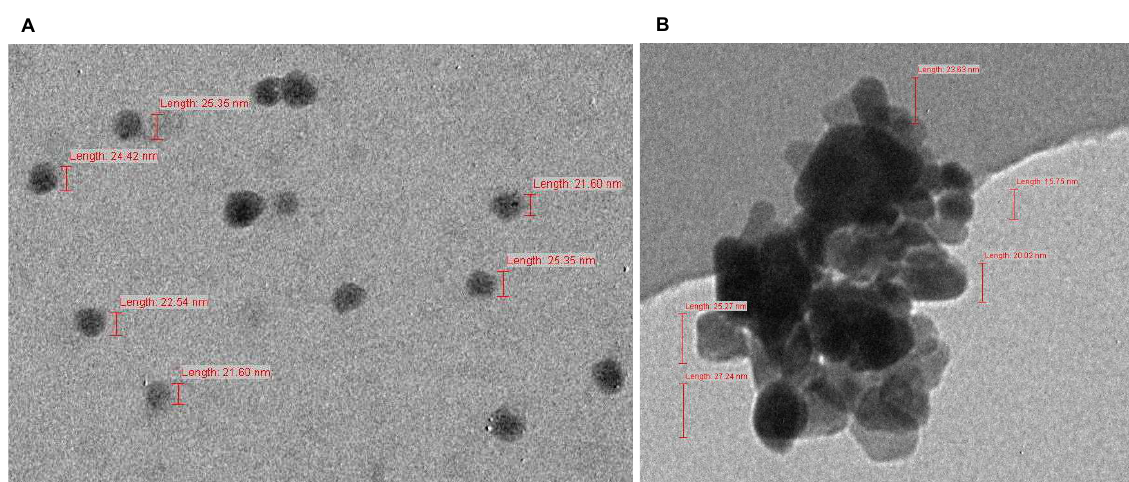
Figure 2. Individual primary ZnO nanoparticles at magnification of 100,000× ( A ) and aggregate-ed ZnO nanoparticles at magnification of 300,000× ( B ), as seen under transmission electron microscope.